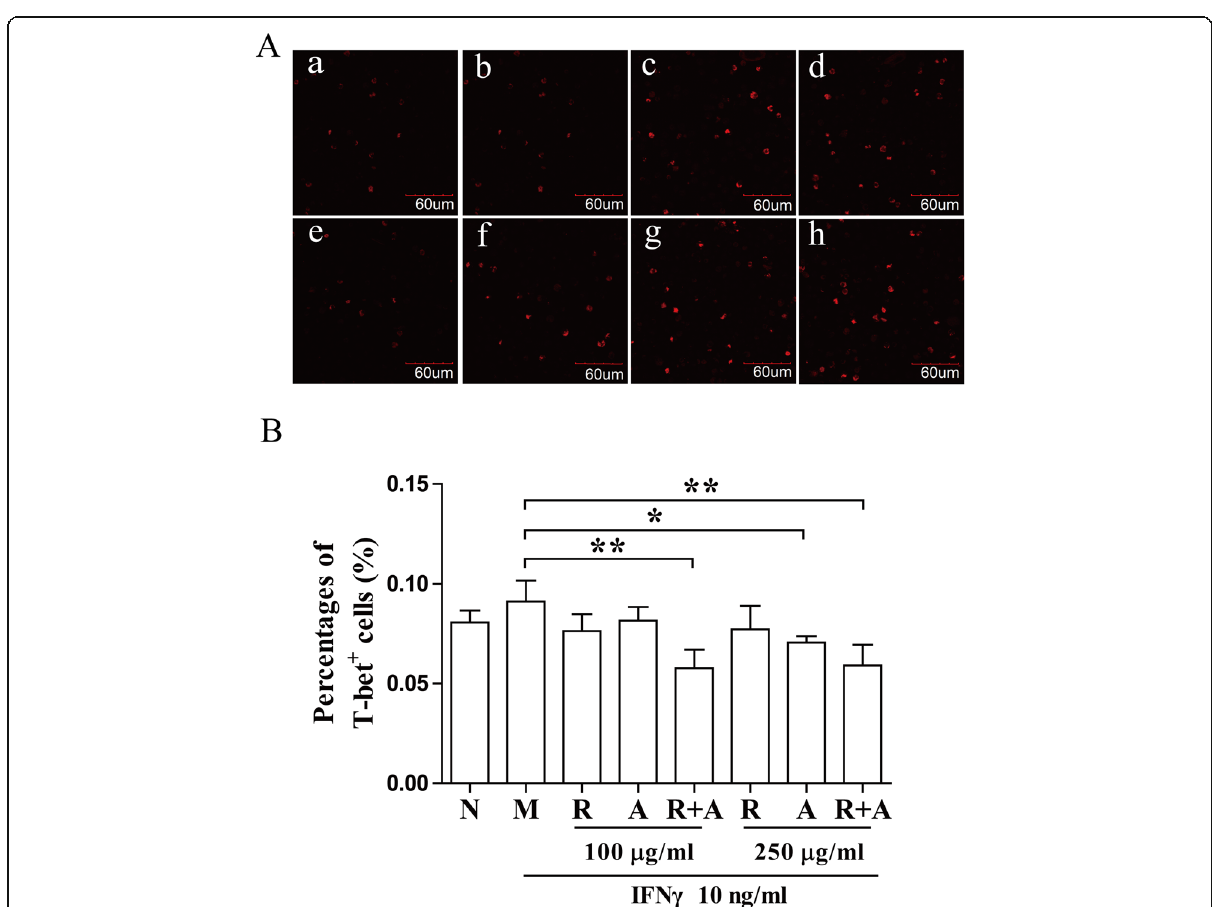
Fig. 8 Interference in the expression and distribution of T-bet in BM cells after 24 h of treatment. Staining for T-bet (red) in BM cells was observed by confocal immunofluorescence microscopy. The stained cells (red) were quantitated with Image J. The scale bar corresponds to 60 μ m throughout. ( b ) The quantified results are presented in a bar chart. a, Normal (N) group; b, Model (M) group; c and f, Radix Astragali (R) group; d and g, Radix Angelicae Sinensis ( a ) group; e and h, Radix Astragali + Radix Angelicae Sinensis (R + A) group; c, d and e were treated with 100 μ g/mL of freeze-dried powders and f, g and h were treated with 250 μ g/mL of freeze-dried powders. Data are presented as the mean ± SD, n = 3. * P < 0.05 and ** P <